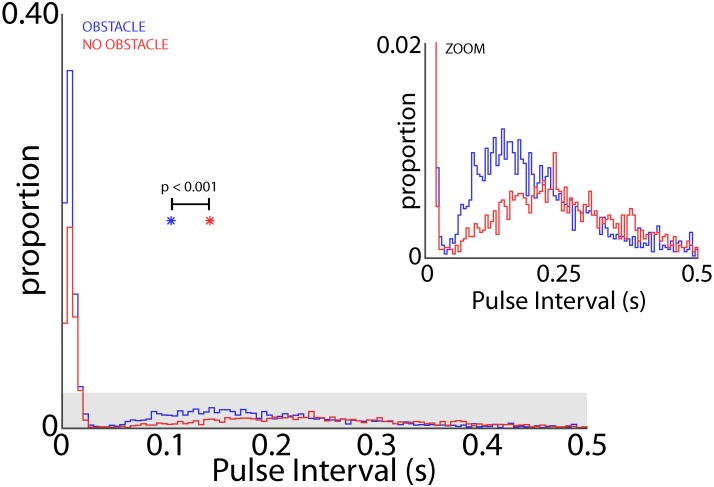
Effect of obstacles on vocal rate. Distribution of pulse intervals (PIs) for all bats in the presence of flight obstacles (blue) and in the absence of flight obstacles (red). Inset shows gray shaded region in larger panel. PI is significant smaller when bats flew in the presence of flight obstacles (p < 0.001, permutation test). Colored asterisks indicate the mean PI’s for the obstacle (blue) and no obstacle (red) conditions.